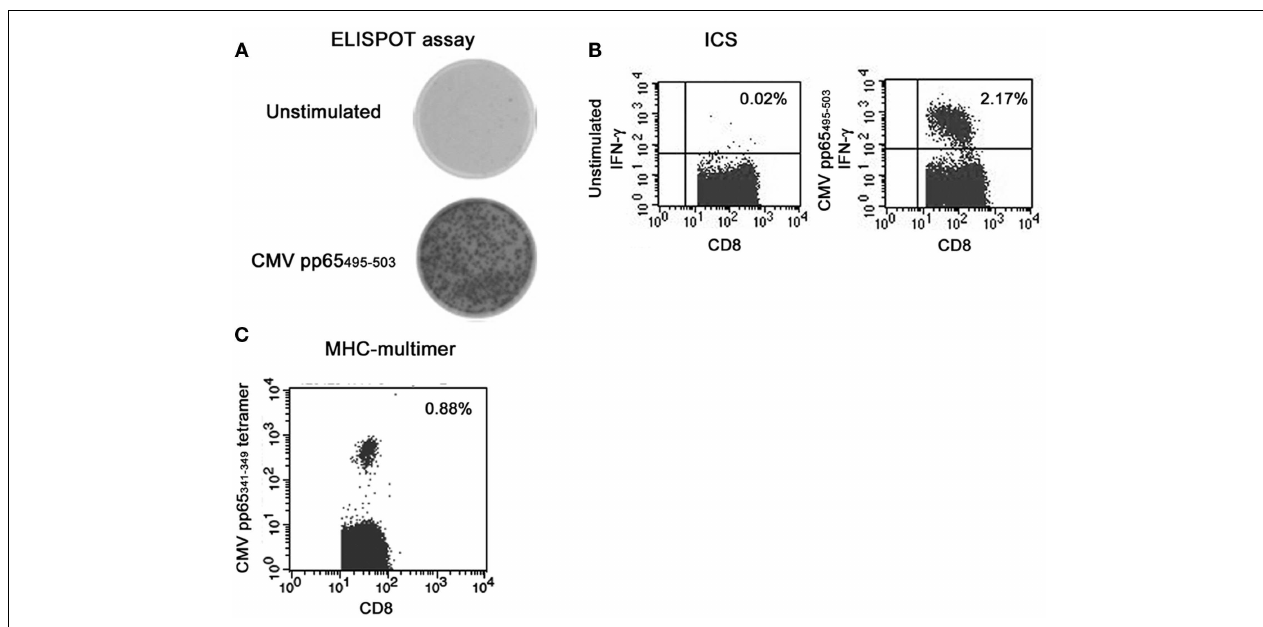
FIGURE 1 | Representative results of immune monitoring of CMV-specificT cells after allogeneic hematopoietic stem cell transplantation (A) ELISPOT assay, (B) intracellular cytokine staining, (C) tetramer